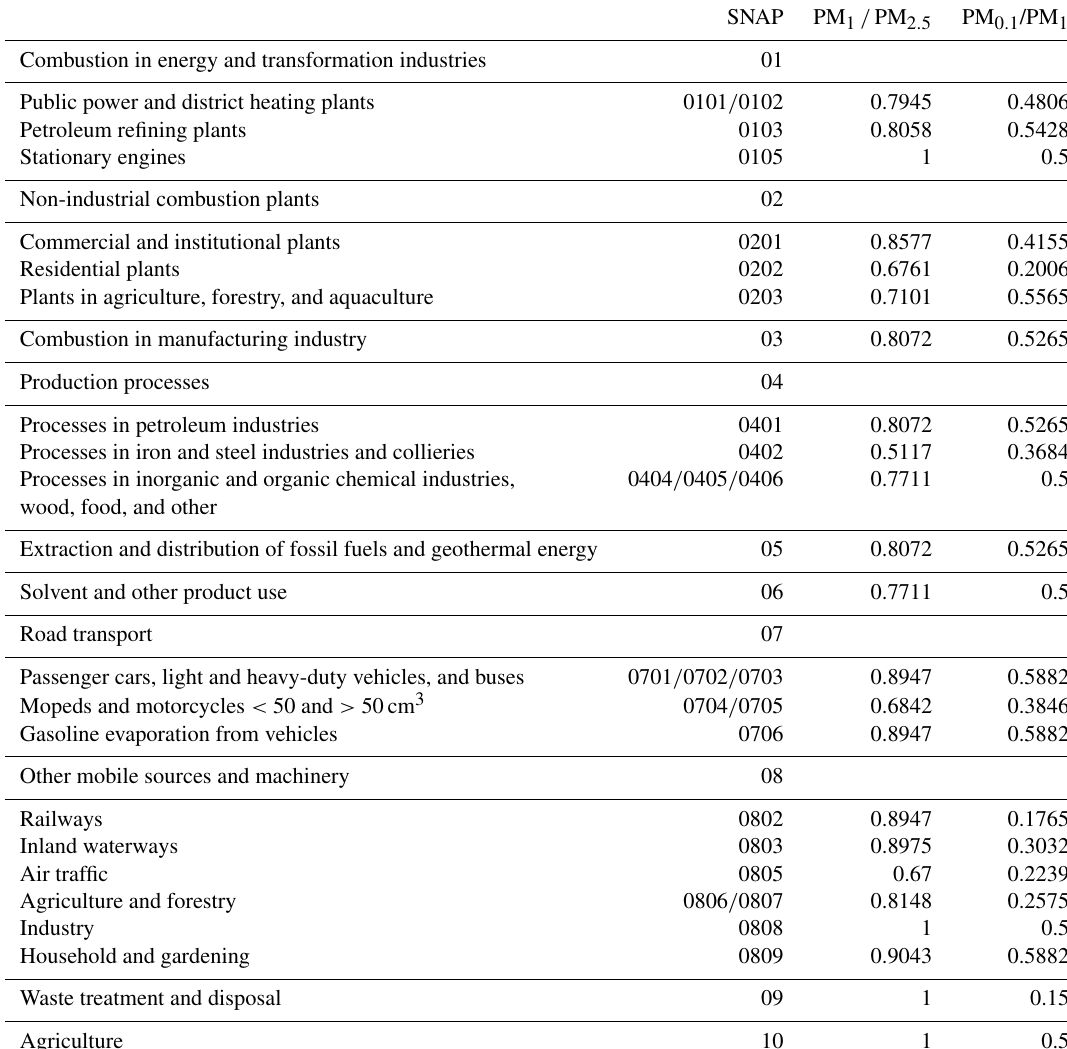
Table A2. Estimation of the size distribution of emissions by estimating the ratios of PM 1 / PM 2 . 5 and PM 0 . 1 / PM 1 for each activity